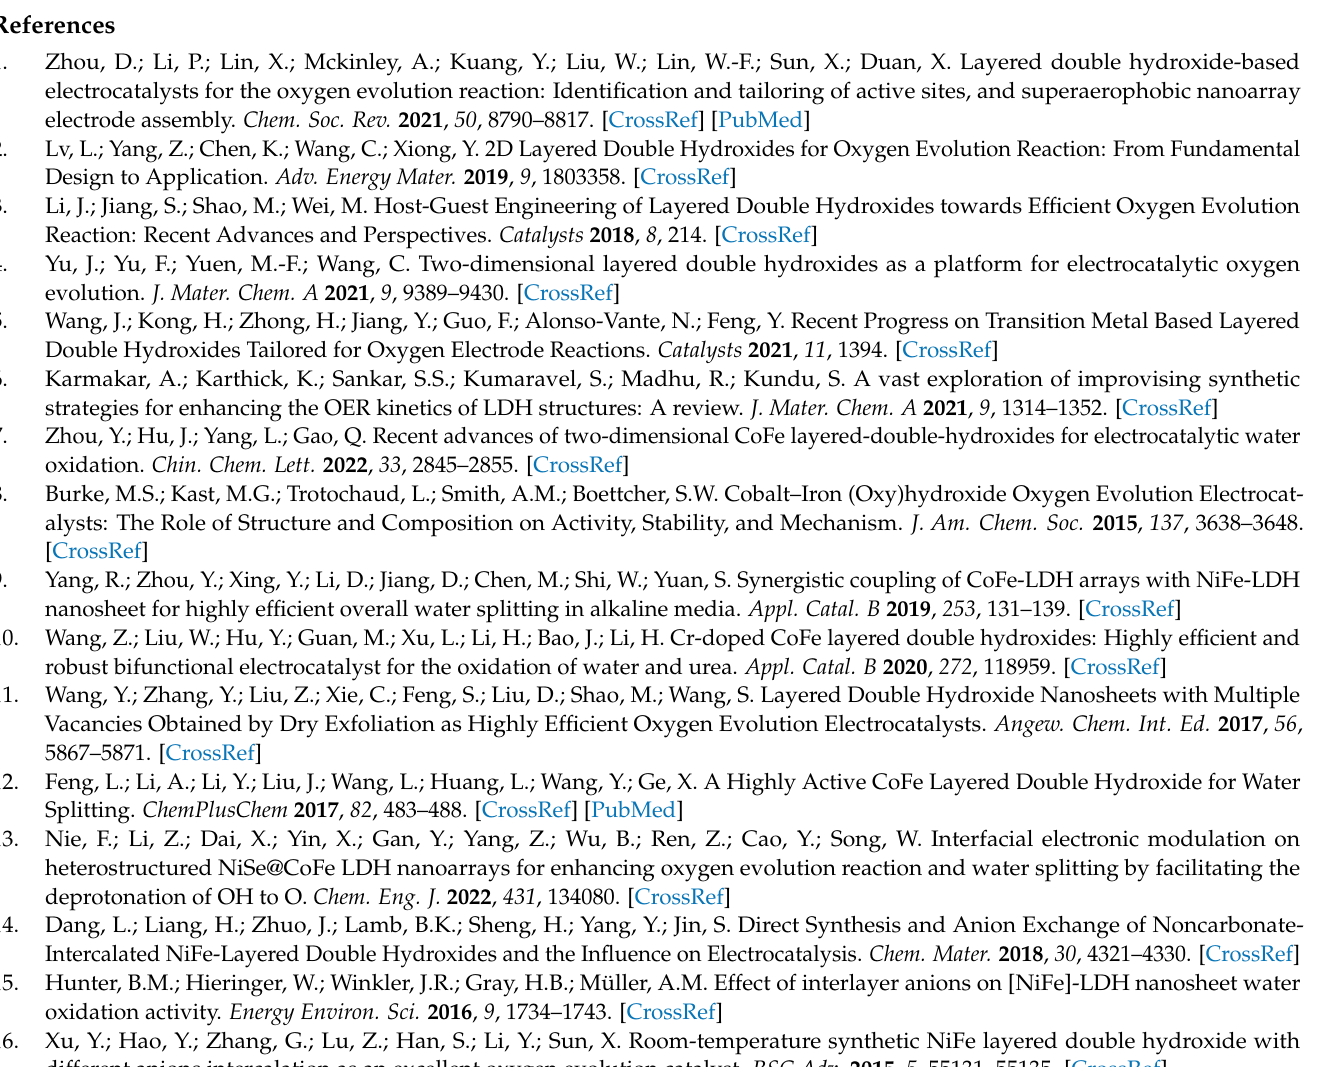
Table S1: Comparison study of CoFe LDH in this work and previously reported similar materials to- ward oxygen evolution reaction. References [9–13,27,38] are citated in the Supplementary